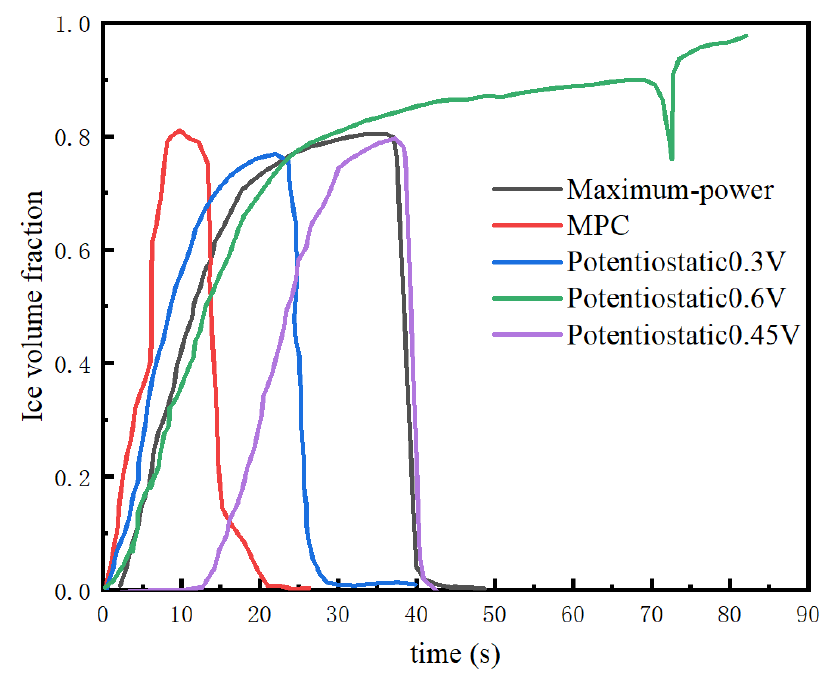
Figure 9. Variation in ice volume fraction in the catalytic layer at − 10 °C for different startup modes.